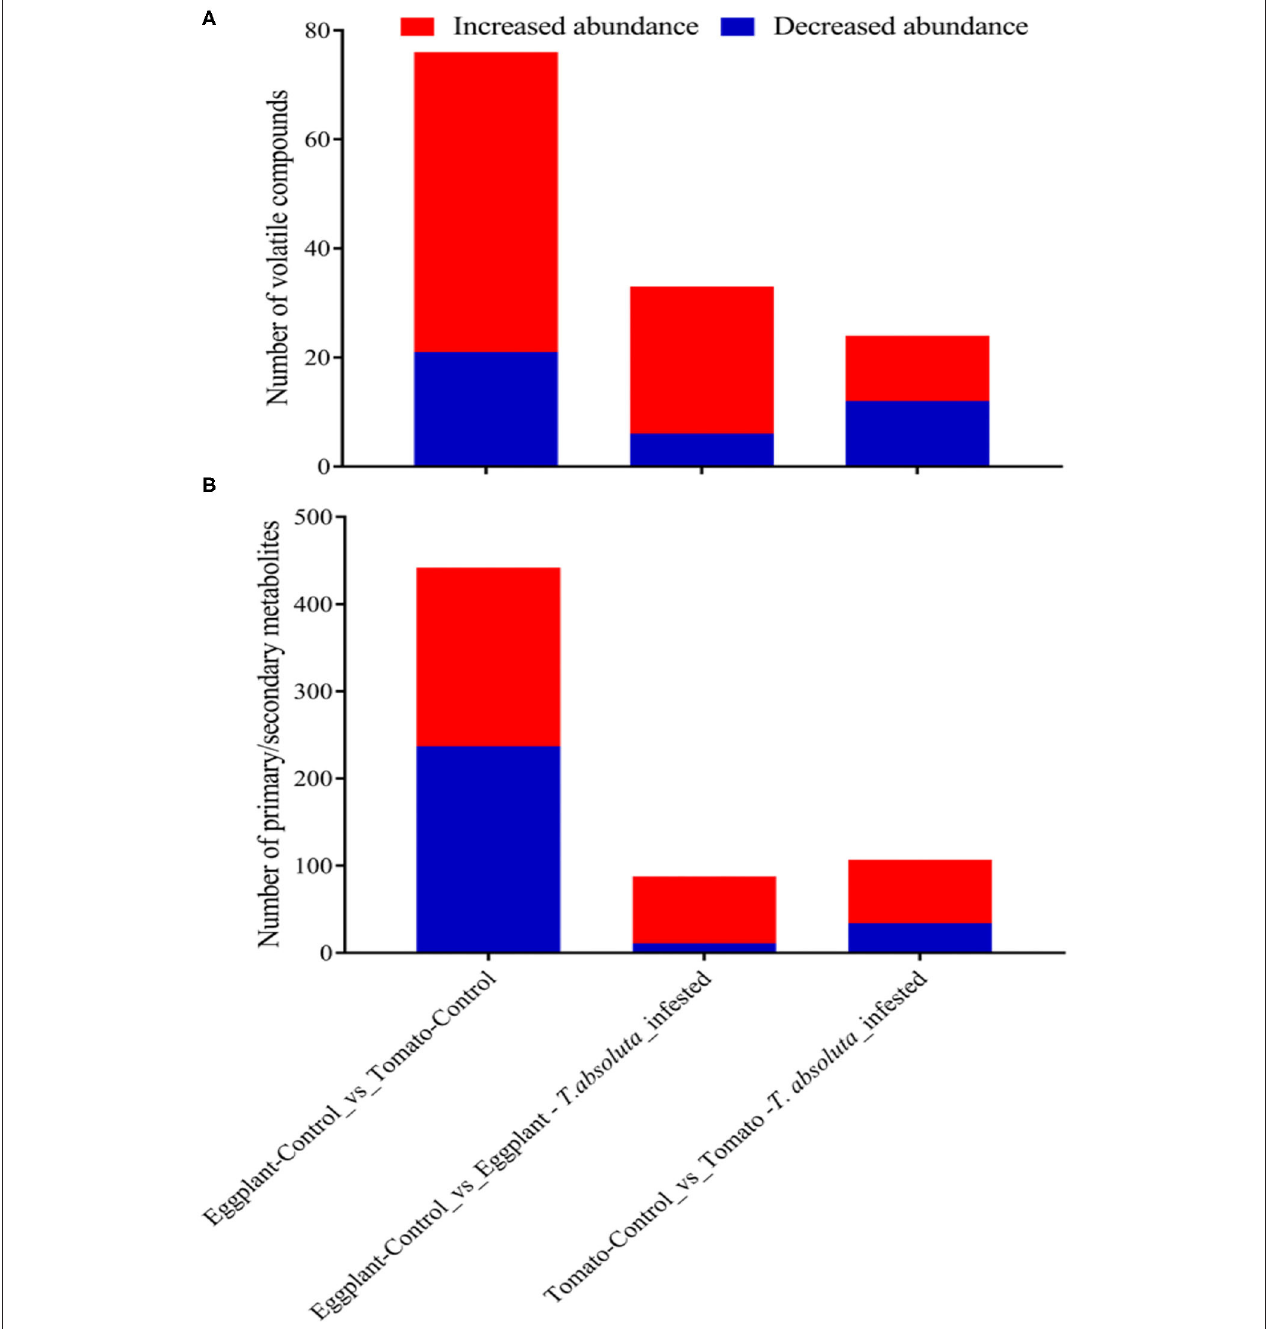
FIGURE 6 | Differentially accumulated compounds in the leaves of tomatoes and eggplants under two different conditions. Discriminant analysis of orthogonal partial least squares with a threshold of log2FC ≥ 1 and variable importance in projection ≥ 1. (A) Differentially accumulated volatile organic compounds. (B) Differentially accumulated primary/secondary